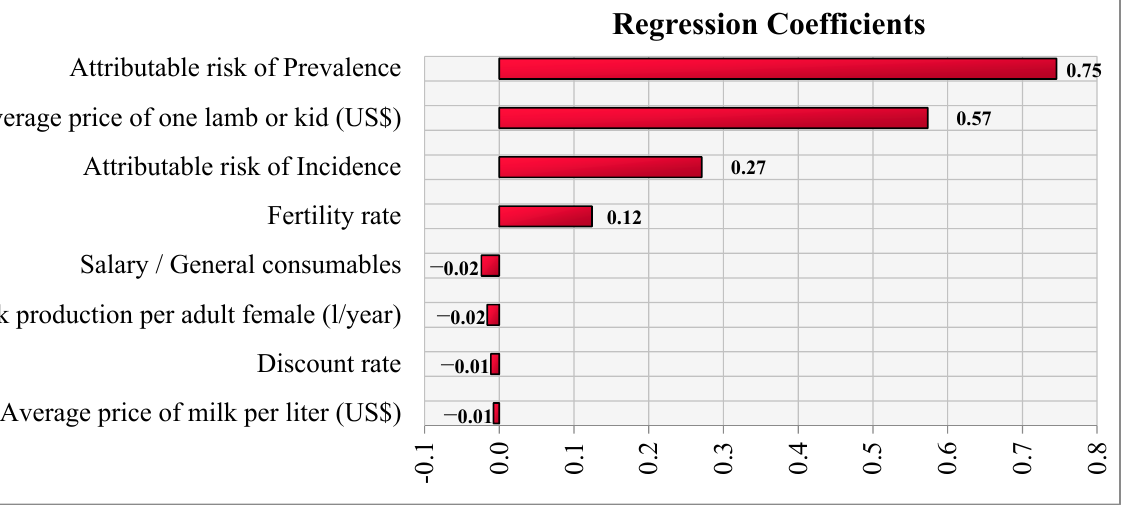
Figure 2. Regression coefficients of the sensitivity analysis for net present value (NPV) of the mass vaccination control programme.